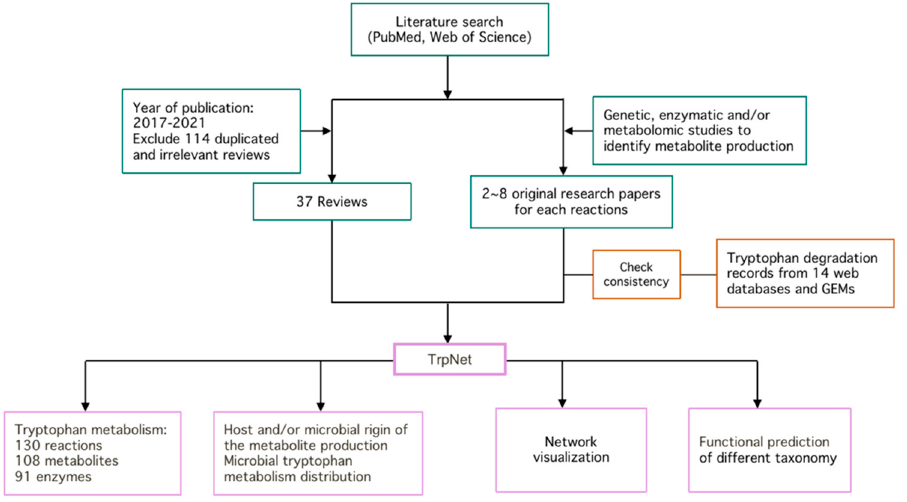
Figure 1. The development of